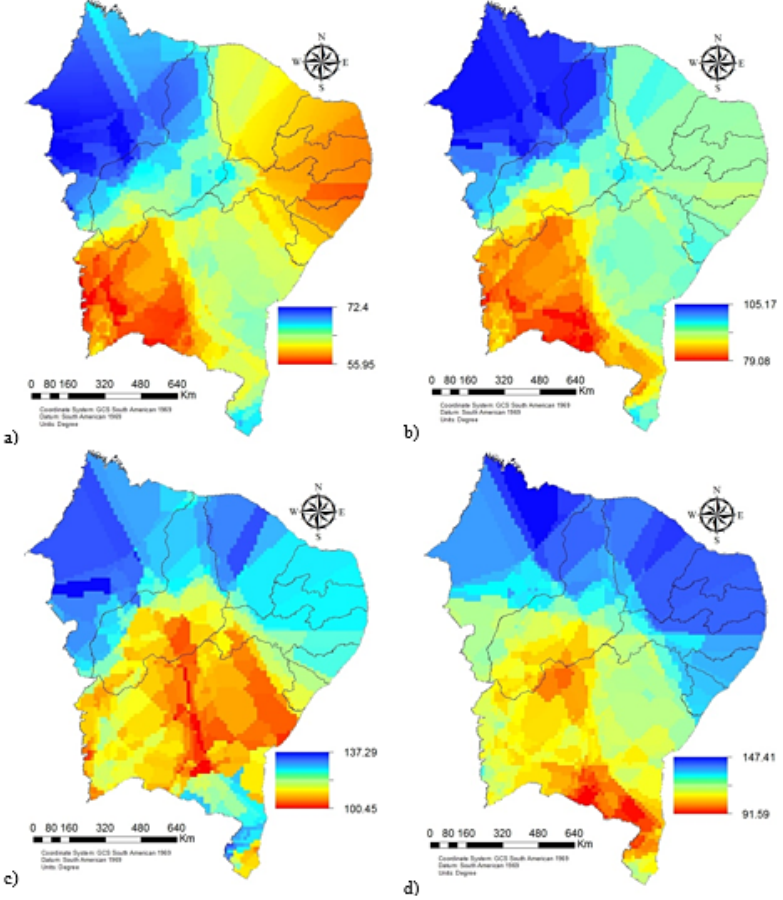
Figure 3. Precipitation amount based on the IDF’s gathered during this study for 1h (a) , 4h (b) , 12h (c) , and 24h (d)